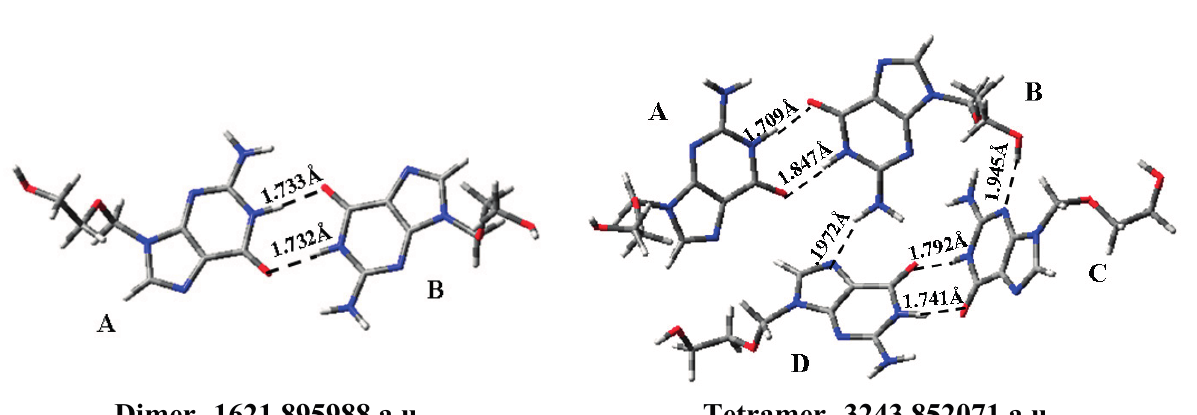
Figure 10. The optimized dimer and tetramer forms in conformer A1 of acyclovir at the B3LYP/6-31G(d,p) level. The H-bonds observed are in Å and the E (RB+HF-LYP) in a. u.